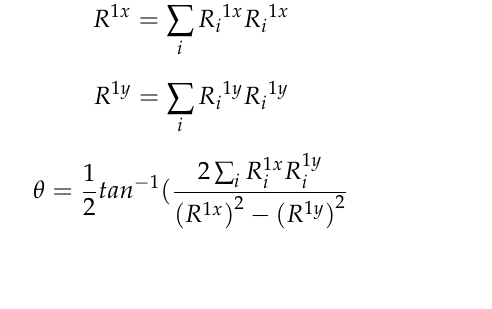
Figure 2. Representation using the circle of Mohr [22].